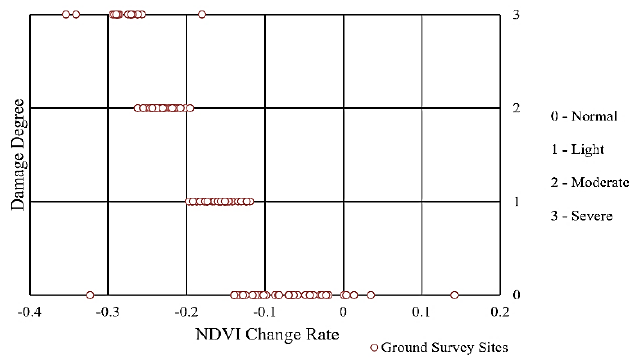
Figure 5. The relationship between the NDVI change rate and damage degree.